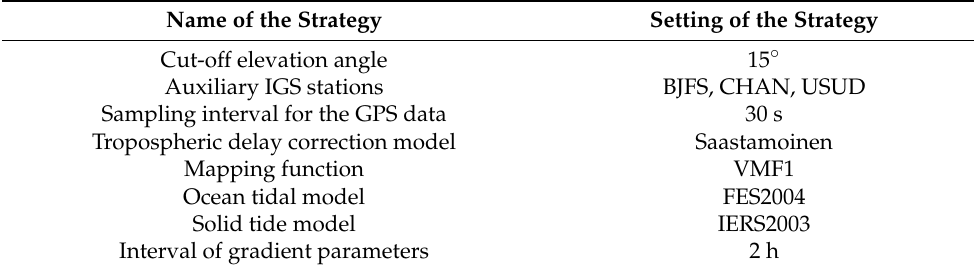
Figure 2. Geographical distribution of Global Navigation Satellite System (GNSS) receivers and radiosonde station in the tomographic area. Table 1. Processing strategies of GAMIT/GLOBK